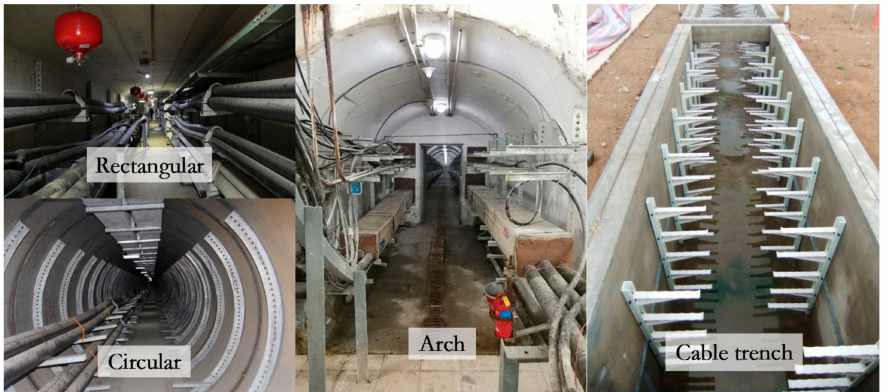
Figure 1. Different types of cable